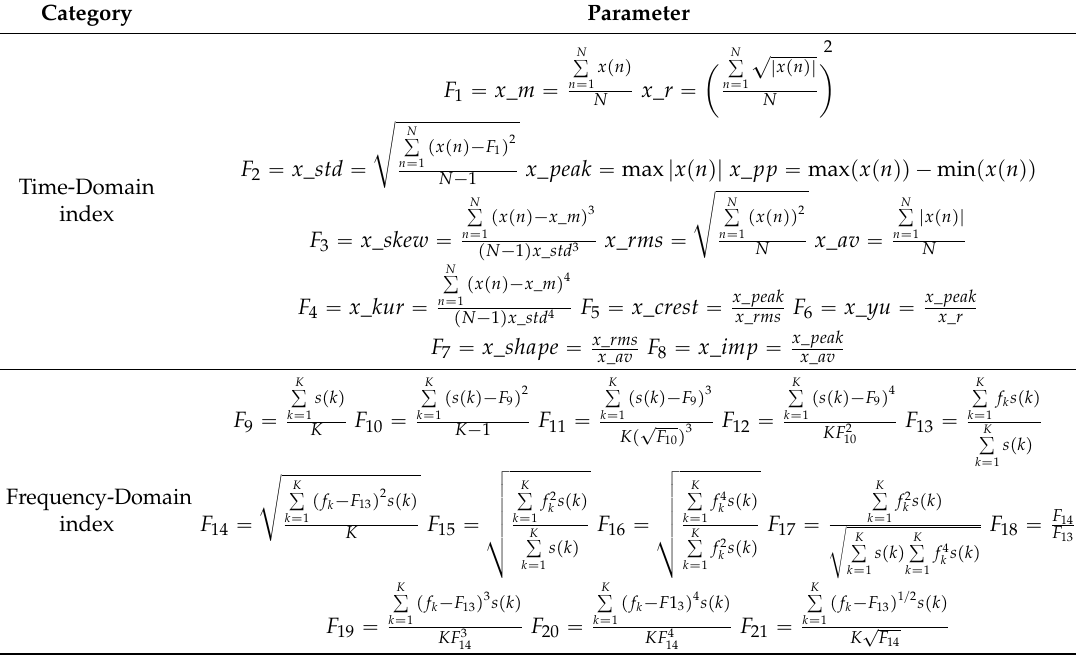
Table 2. The contrastive feature parameters.